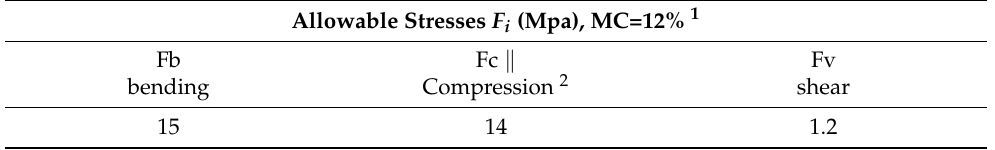
Table 1. Allowable strength values for Guadua A.K.